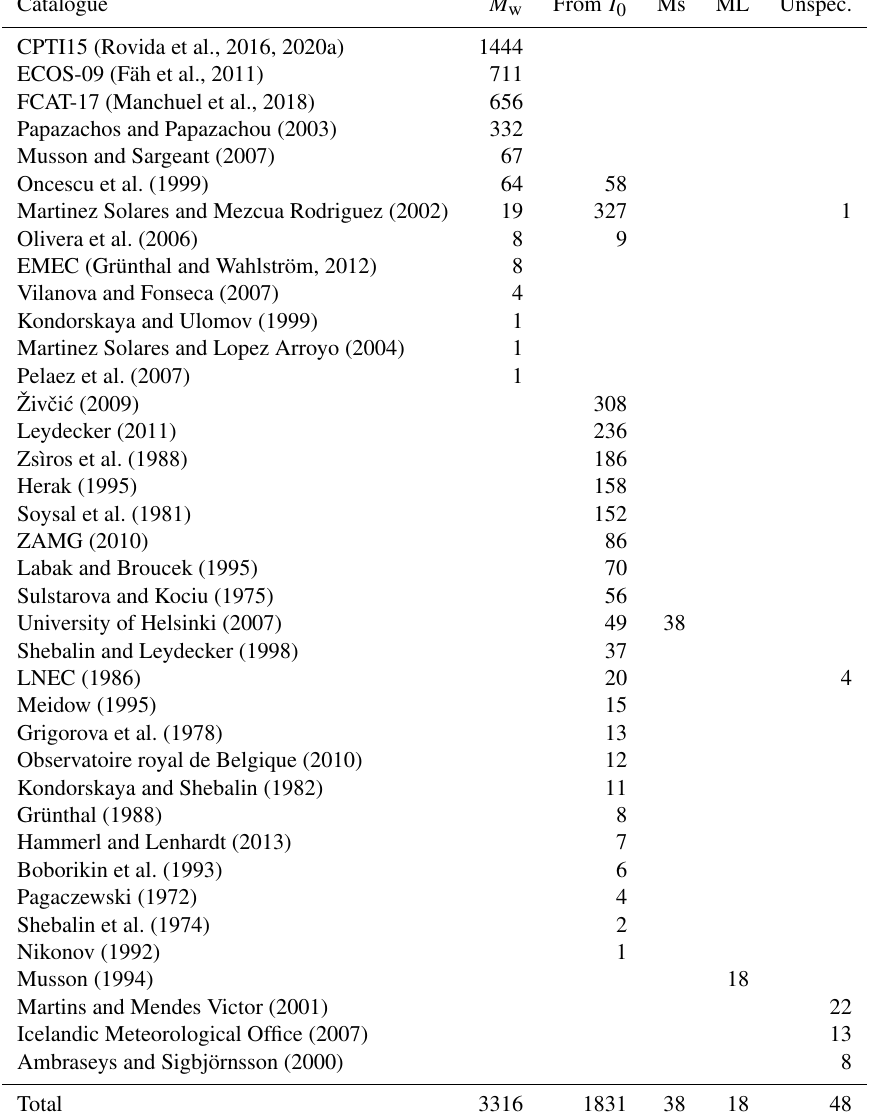
Table 3. Catalogues considered in EPICA and magnitude determination strategy.